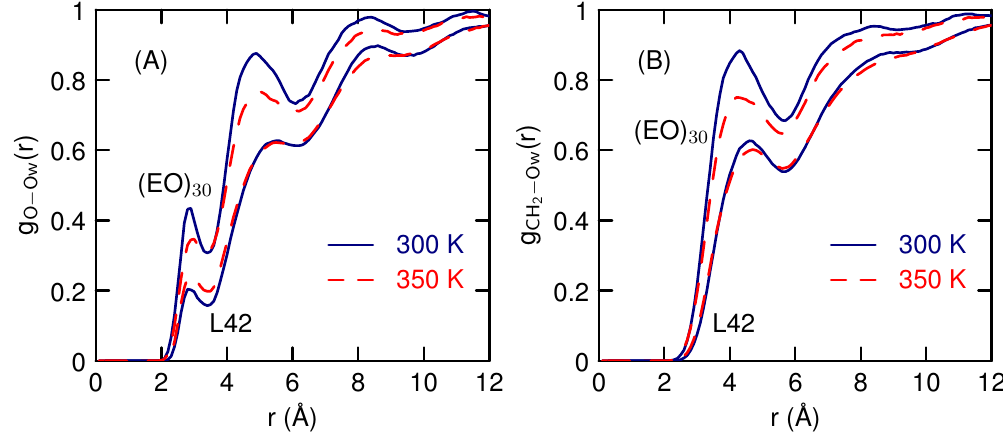
Figure 7. Water oxygen-polymer oxygen ( A ) and water oxygen-polymer CH 2 ( B ) radial distribution functions at 300 and 350 K for a single (EO) 30 (The top two curves) and L42 (The bottom two curves)